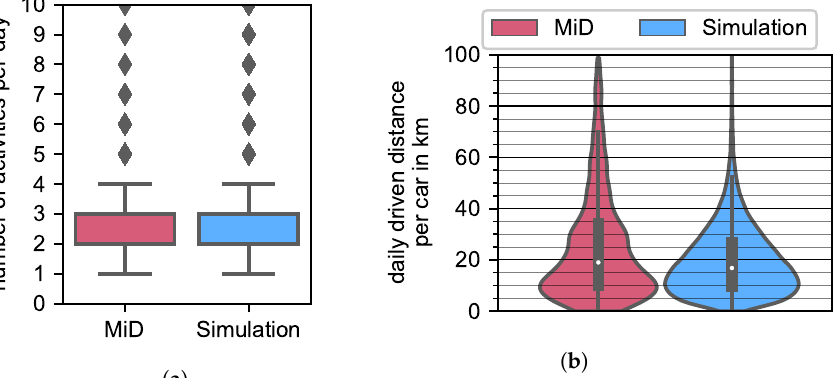
Figure 11. Comparison of the simulation output with MID survey data in terms of daily distances and number of activities. ( a ) Number of activities per car and day. ( b ) Distance driven per car and day.